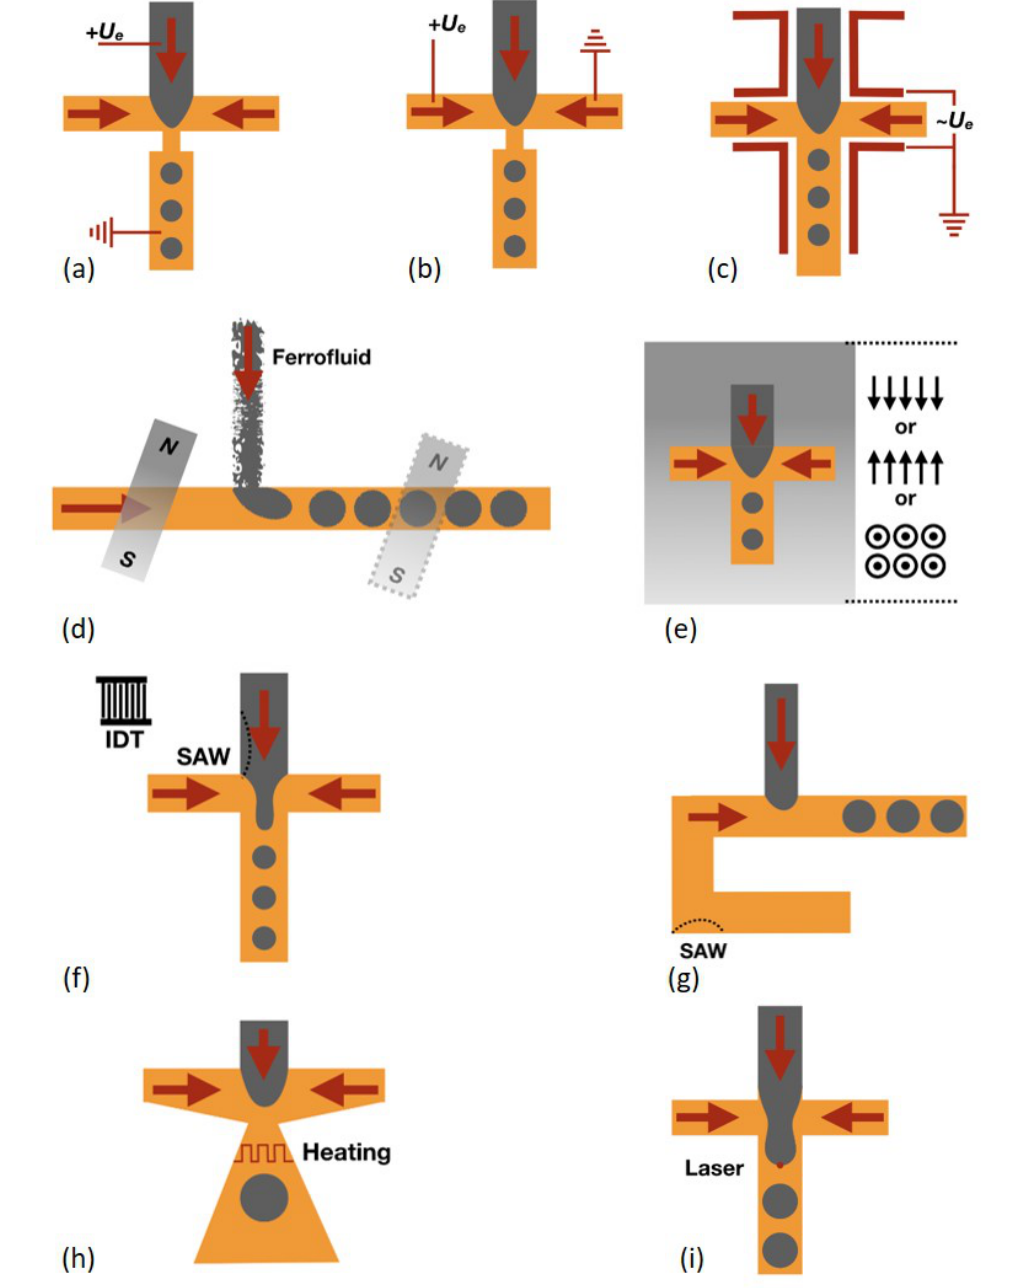
Figure 3. Electrical control methods: ( a ) Electrical field parallel to the flow. ( b ) Electrical field perpendicular to the flow. ( c ) Electrodes arrangement without contact with fluids. Magnetic control methods: ( d ) Magnet placed either upstream or downstream. ( e ) Magnet can be placed parallel and perpendicular to the flow direction or out-of-plane. Acoustic control methods: ( f ) SAW affects the liquid-liquid interface. ( g ) SAW affects the continuous phase. Thermal control methods: ( h ) Resistive heater at the junction. ( i ) Laser induced thermal effect on the